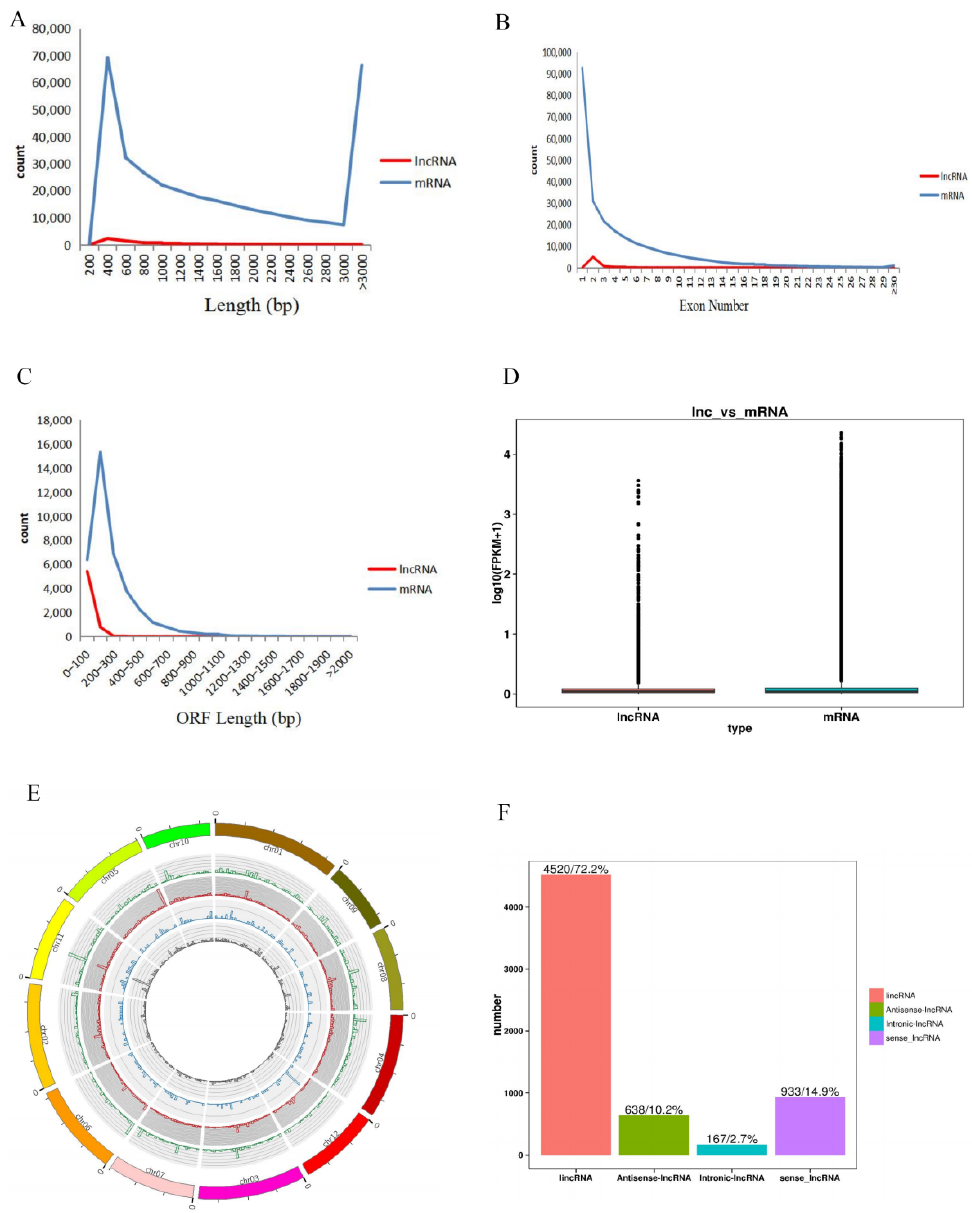
Figure 3. Differences in structure and expression between lncRNAs and mRNAs. ( A ) Length distributions of lncRNAs and mRNAs. ( B ) Distribution of predicted exon numbers in lncRNAs and mRNAs. ( C ) Distribution of ORF (open reading frame) length. ( D ) Overall expression levels of lncRNAs and mRNAs in Francis. ( E ) The distribution of lncRNAs among 12 chromosomes. The four concentric rings correspond to the expression levels of sense lncRNAs, lincRNAs, intronic lncRNAs, and antisense lncRNAs, from outer to inner. ( F ) The proportions of different types of lncRNAs. To evaluate the conservation of the identified lncRNAs, the lncRNAs were aligned with the known plant lncRNAs in the NONCODE database (http://www.noncode.org/index. php (accessed on 30 December 2021)) by BLASTN. Only 81 lncRNAs were comparable